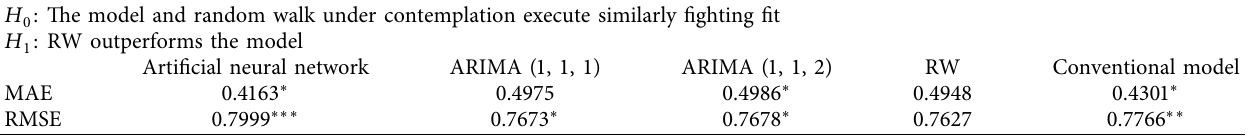
Table 6: The Diebold–Mariano future prediction accuracy